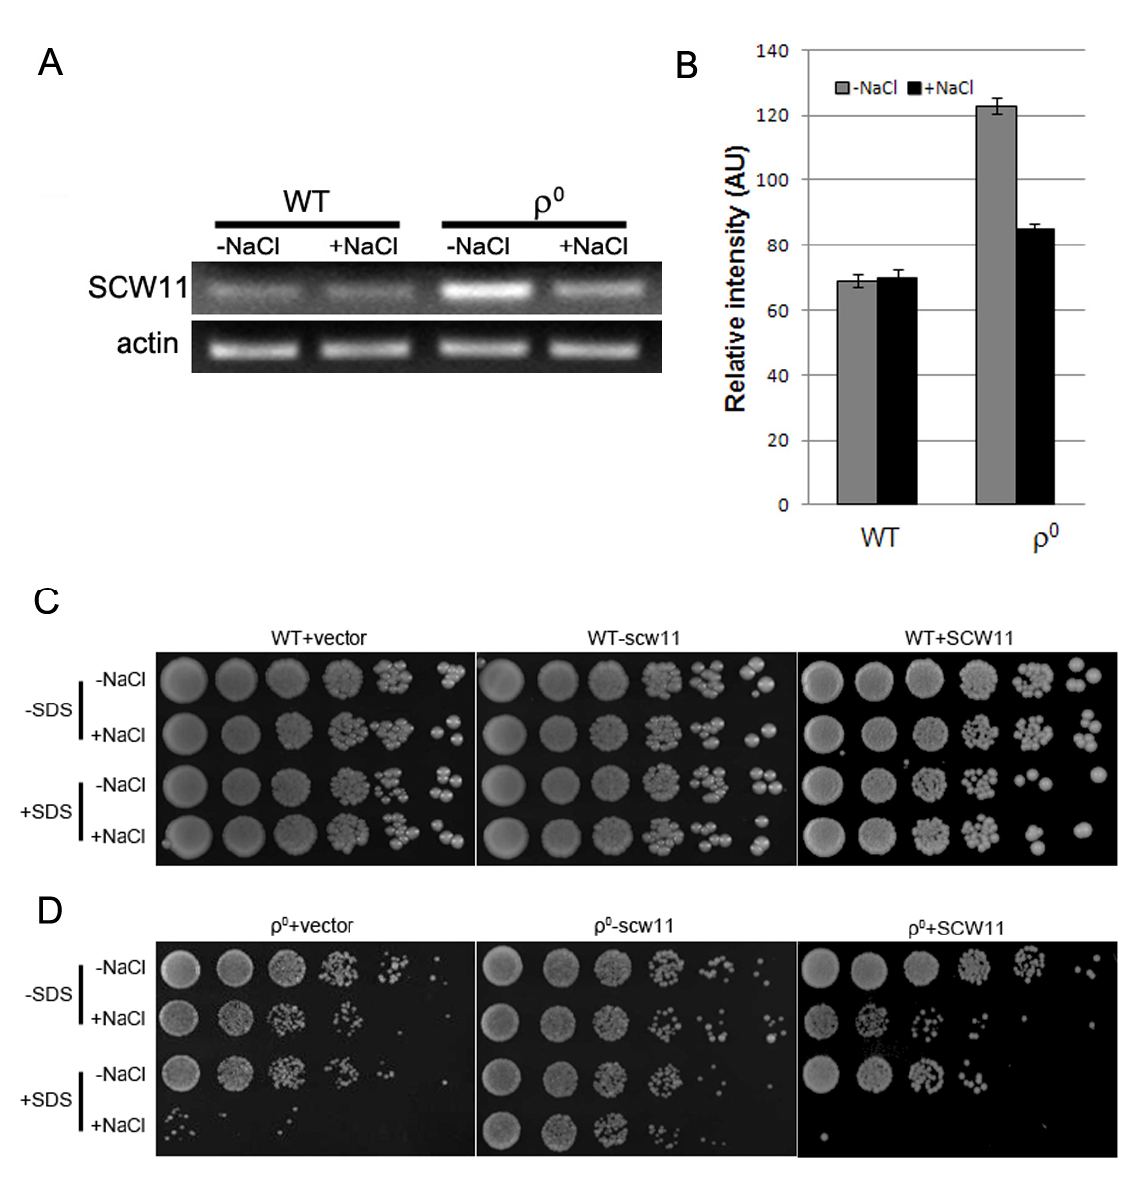
FIGURE 2: (A) RT-PCR analysis of ρ 0 cells showing SCW11 expression upregulated compared to WT. SCW11 expression in ρ 0 cells was de- creased when treated with 0.6 M NaCl for 30 min, but still higher than in WT cells. (B) Quantitative analysis of the RT-PCR bands from three independent experiments. (C) and (D) The cell wall gene SCW11 is involved in salt stress-induced cell death in ρ 0 cells. (C) When treated with NaCl, SDS, or both, no apparent change is observed in the growth of WT cells when SCW11 is either deleted or overexpressed. (D) Deletion of SCW11 in ρ 0 cells (ρ 0 -scw11) increases their resistance to salt; SCW11 overexpression (ρ 0 +SCW11) causes cells to become more sensitive to SDS after NaCl treatment (0.6 M NaCl for 1 hr). The BG1805 empty vector (WT/ρ 0 +vector) was used as a negative control. Cells were spotted on YPG using 4 μl of 1:5 serial dilutions and cultured at 30 ο C for 3-4